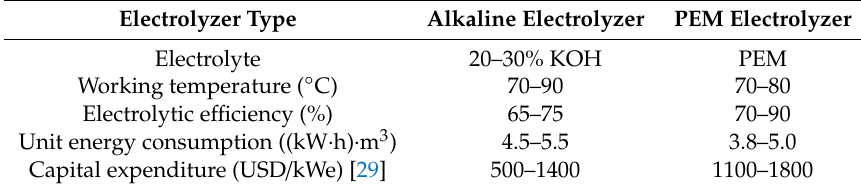
Table 5. Comparison of water electrolysis hydrogen production